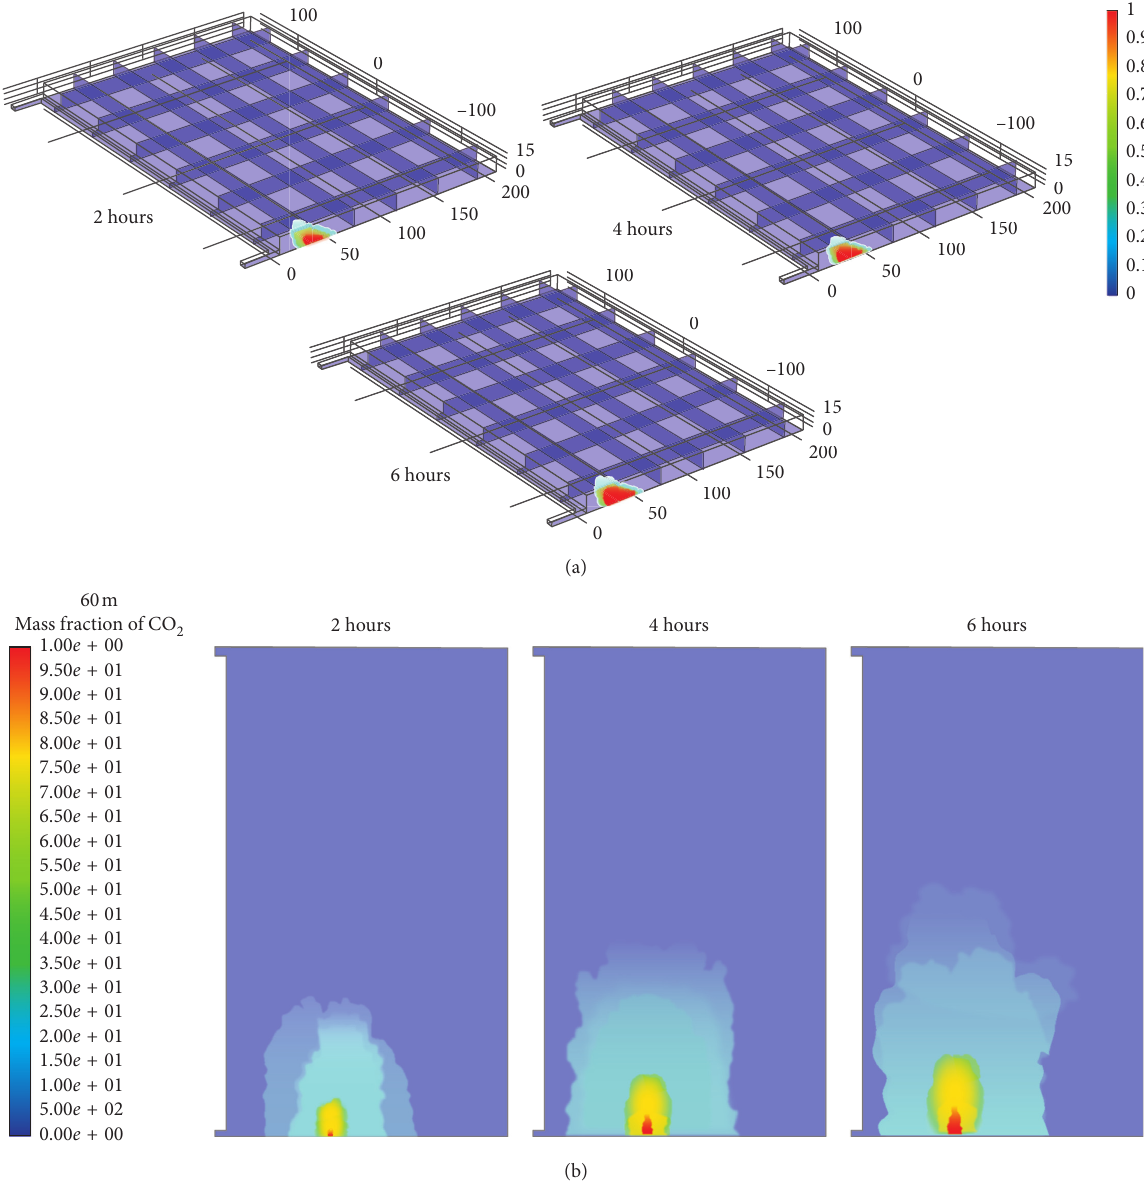
Figure 14: CO 2 distribution characteristics during 6-hour injection. (a) Three-dimensional simulation of carbon dioxide diffusion. (b) Plane simulation diagram of carbon dioxide